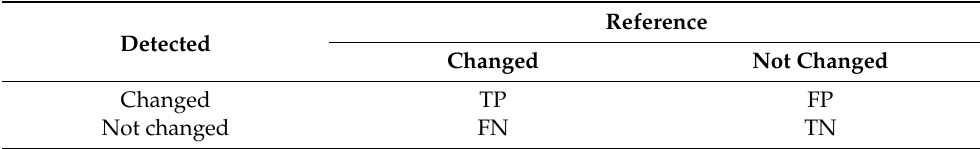
Table 4. Simple example of matrix confusion of a binary